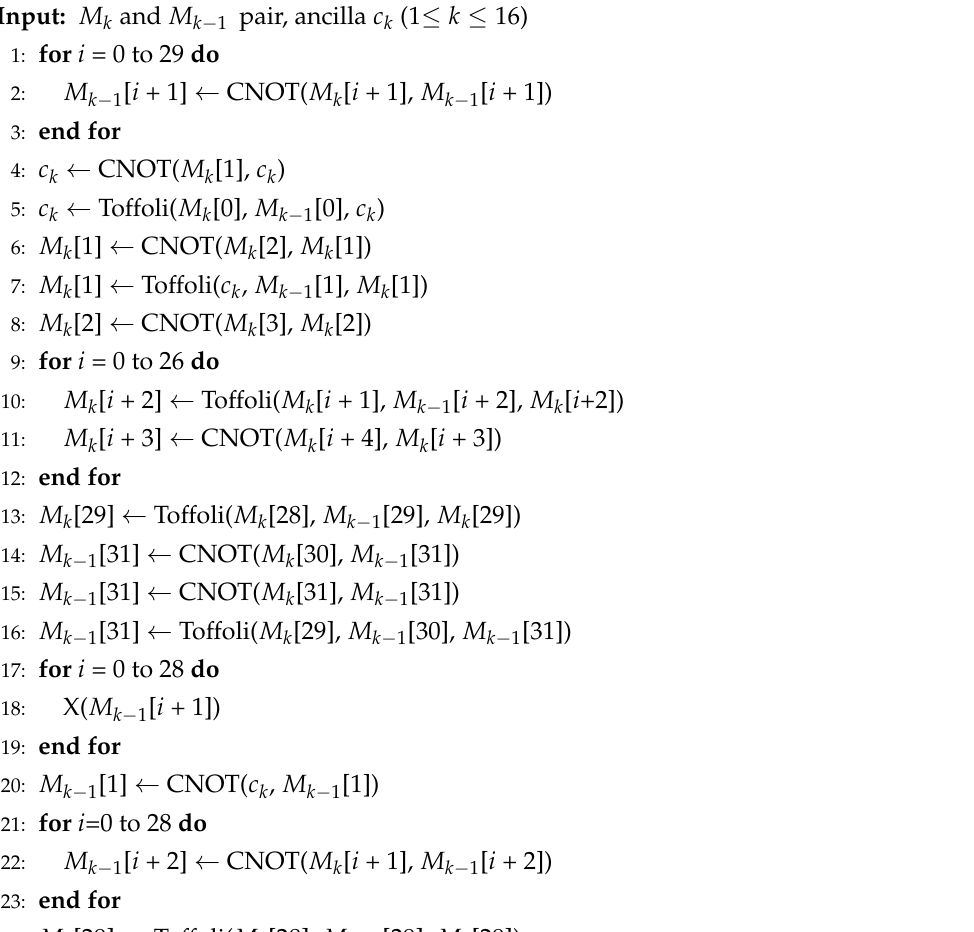
Algorithm 1 Parallel quantum adder of